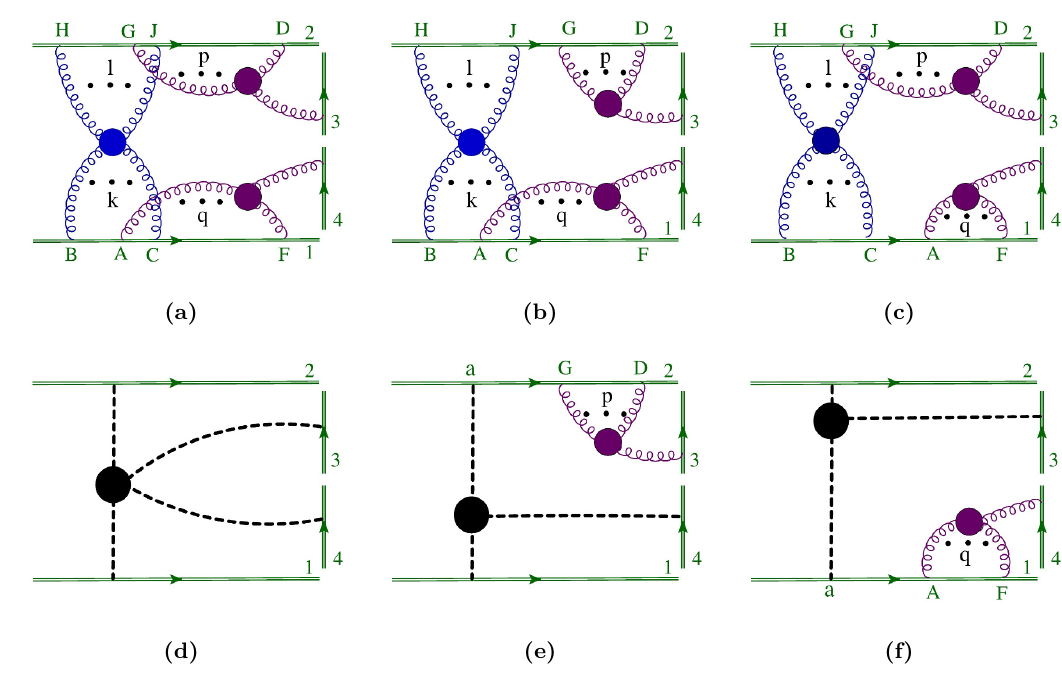
Figure 18. Fused-Webs for Cweb W (1 , 1 , 1)